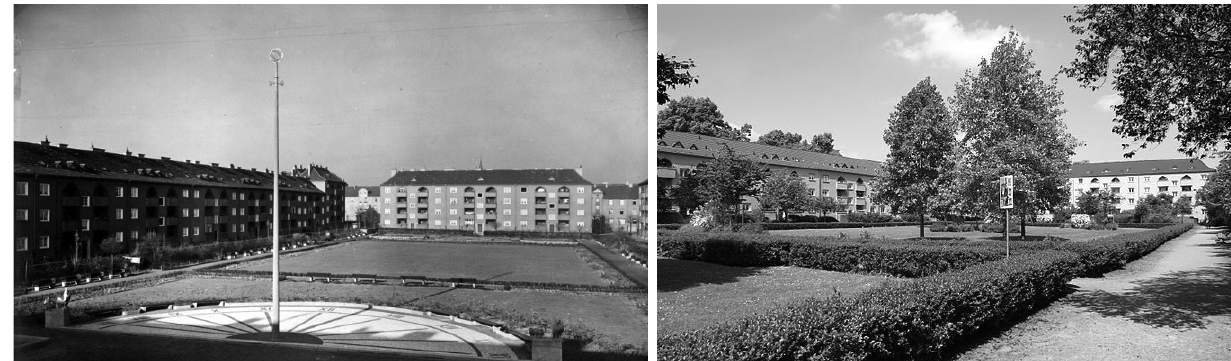
Figure 11. From left to right: W. Riphahn, historical image of Grüner Hof , Köln-Mauenheim (1922–1924 (Schmölz, 1926); Interior of the courtyard (Heinrich,